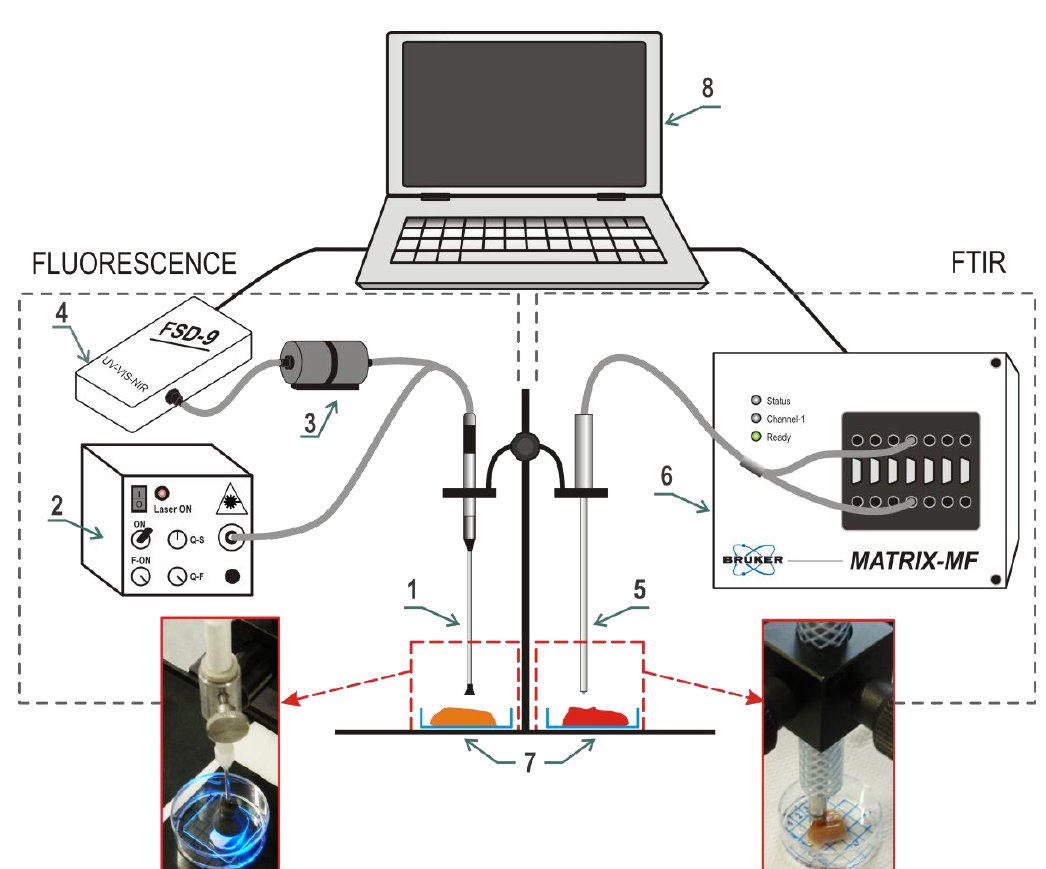
Figure 2. Experimental setups for fluorescence (left) and mid infrared (MIR) (right) spectral measurements: 1—fluorescence probe; 2—laser light source; 3—cut-off fluorescence filter; 4—